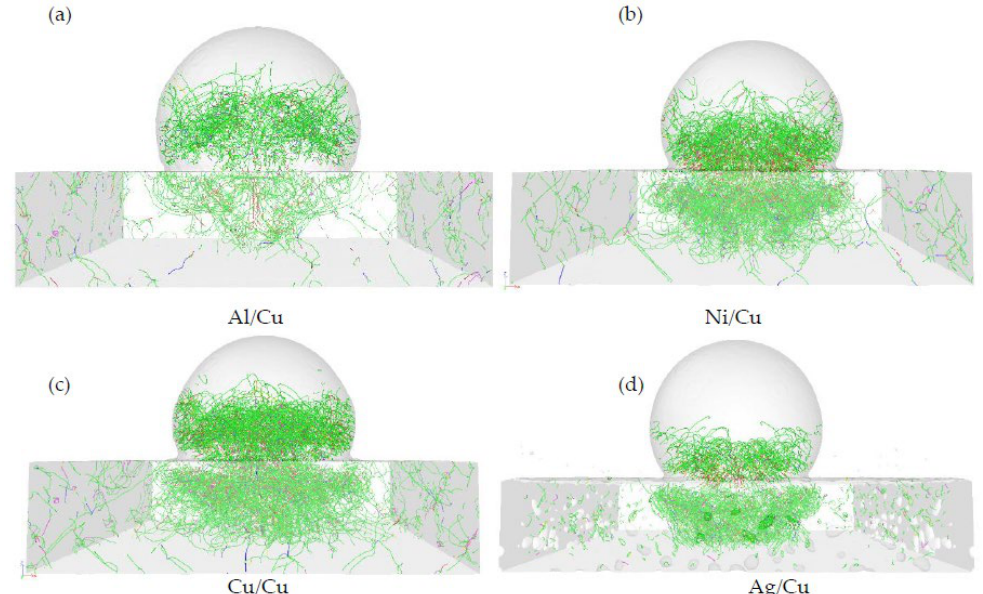
Figure 8. The evolution of dislocation segment in the particle / substrate interfacial zone during the cold gas dynamic spray processes at 10 ps for particles of ( a ) Al ( b ) Ni ( c ) Cu and ( d ) Ag impacting Cu substrate.